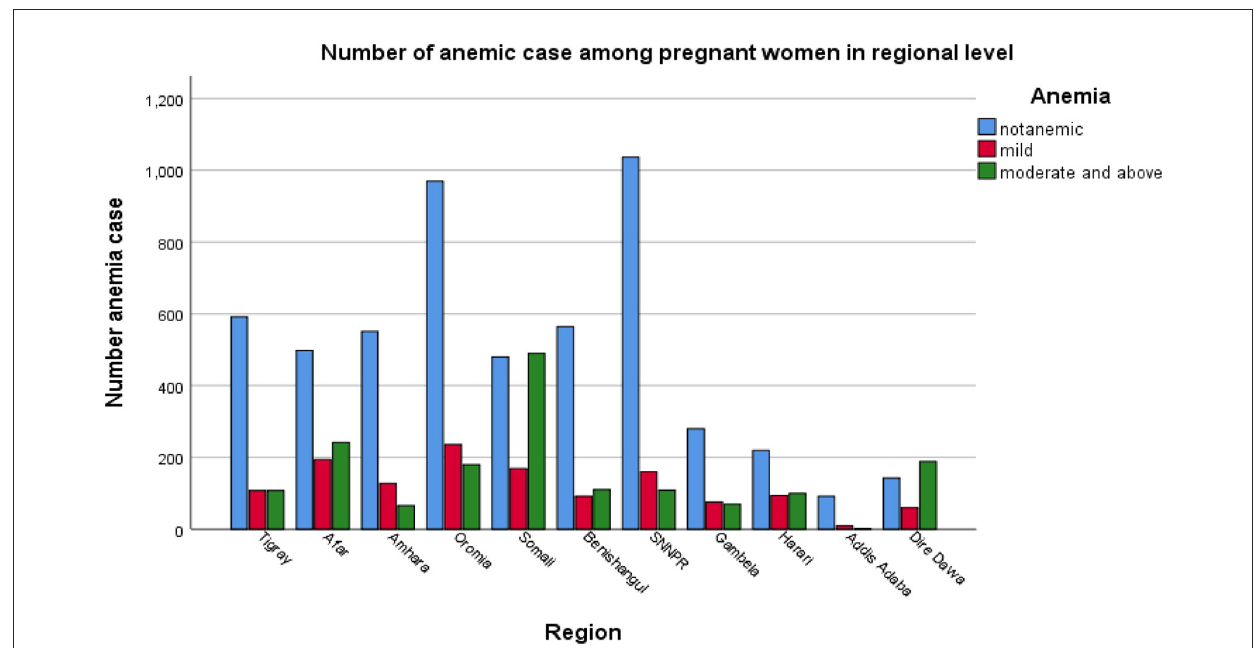
FIGURE4 The bar chart presentation of anemia levels among pregnant women in Ethiopia’s administrative